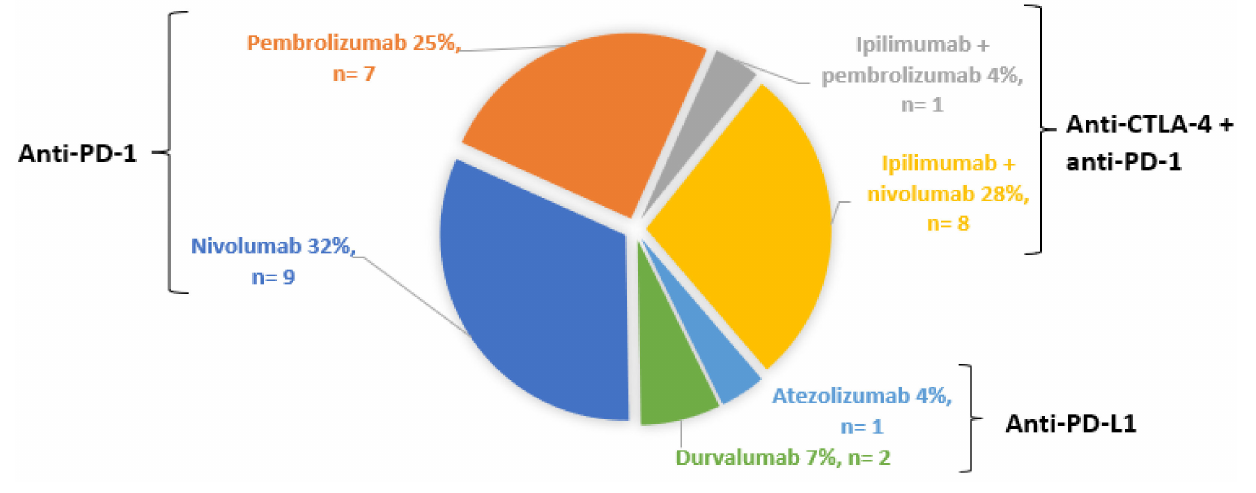
Figure 1. Distribution of ICPIs.